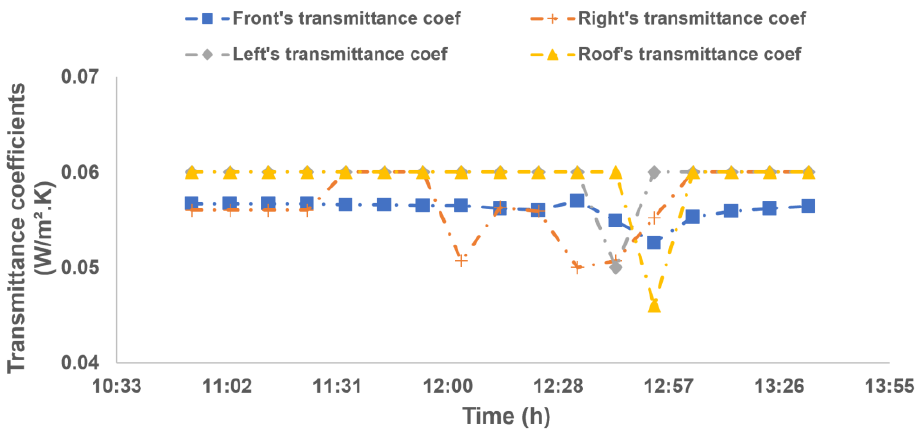
Figure 13. Numerical Transmittance coefficients.